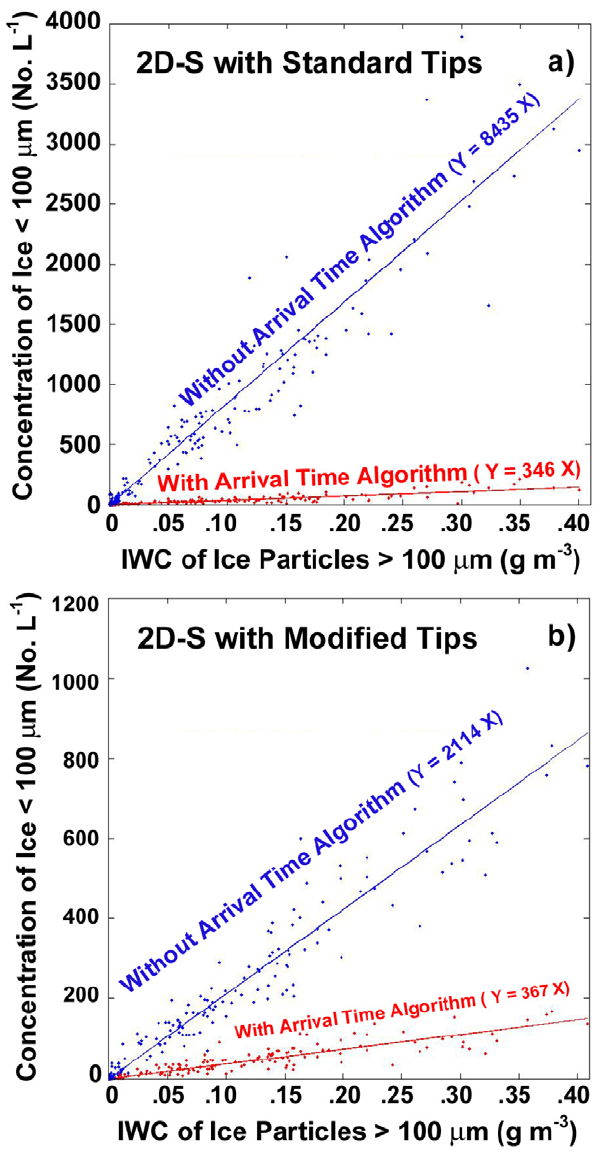
Figure 7. Scatter plots of the concentration of ice particles < 100  m versus ice water Fig. 7. Scatter plots of the concentration versus ice water content content. Data collected in large ice aggregates with two 2D-S probes installed side-by-side of ice particles < 100µm. Data collected in large ice aggregates on the SPEC Learjet ( Figs. 3 - 6 ). One probe (a) had standard probe tips and the other probe with two 2D-S probes installed side-by-side on the SPEC Learjet (b) was equipped with probe tips modified to reduce shattering. Effect of the arrival time (Figs. 3–6). One probe (a) had standard probe tips and the other algorithm to remove shattering is shown on each plot. probe (b) was equipped with probe tips modified to reduce shat- tering. Effect of the arrival time algorithm to remove shattering is shown on each